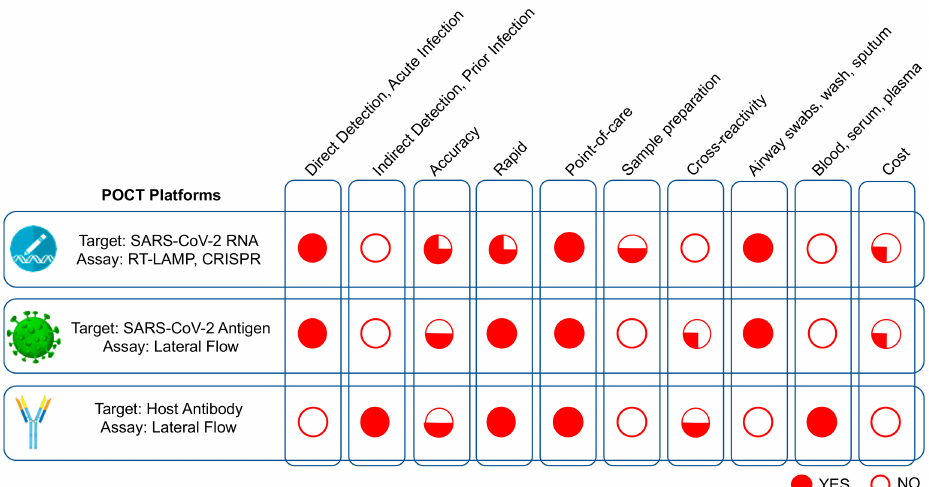
Figure 1. Features of various COVID-19 point-of-care diagnostic test (POCT) technology platforms. RT-PCR, reverse transcription polymerase chain reaction; CRISPR, cluster regularly interspaced short palindromic repeats; RT-LAMP, reverse transcription loop-mediated isothermal amplification. Adapted and modified from Ghaffari et al., BioProcess International, 2020